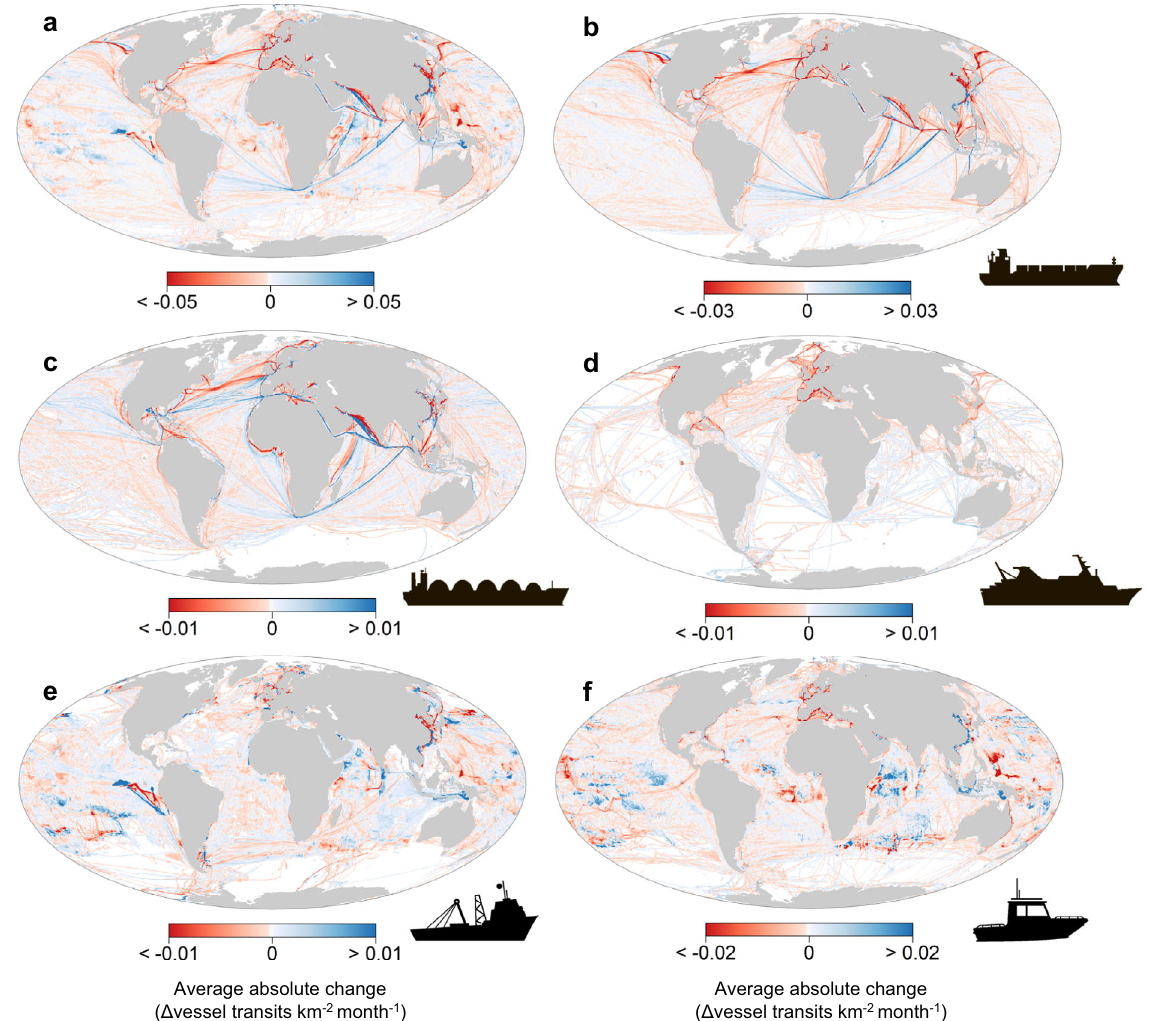
Fig. 3 Global changes in vessel traf fi c density. Maps showing the average of the absolute difference in traf fi c density (number of vessel transits per square kilometre per month) between equivalent months (January – June) from 2020 and the reference year 2019. Absolute differences derived using cell- by-cell subtraction. Negative (red) cells indicate an average reduction during 2020. Scale range values re fl ect the absolute maxima (99th percentile). Vessel categories: a all vessels, b cargo, c tanker, d passenger, e fi shing and f other